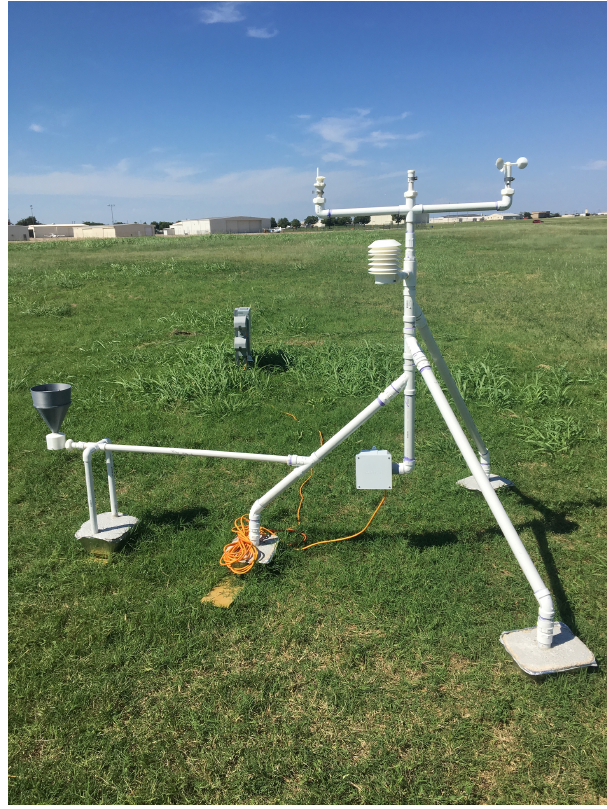
Figure 2. 3D-printed weather station upon initial installation in the